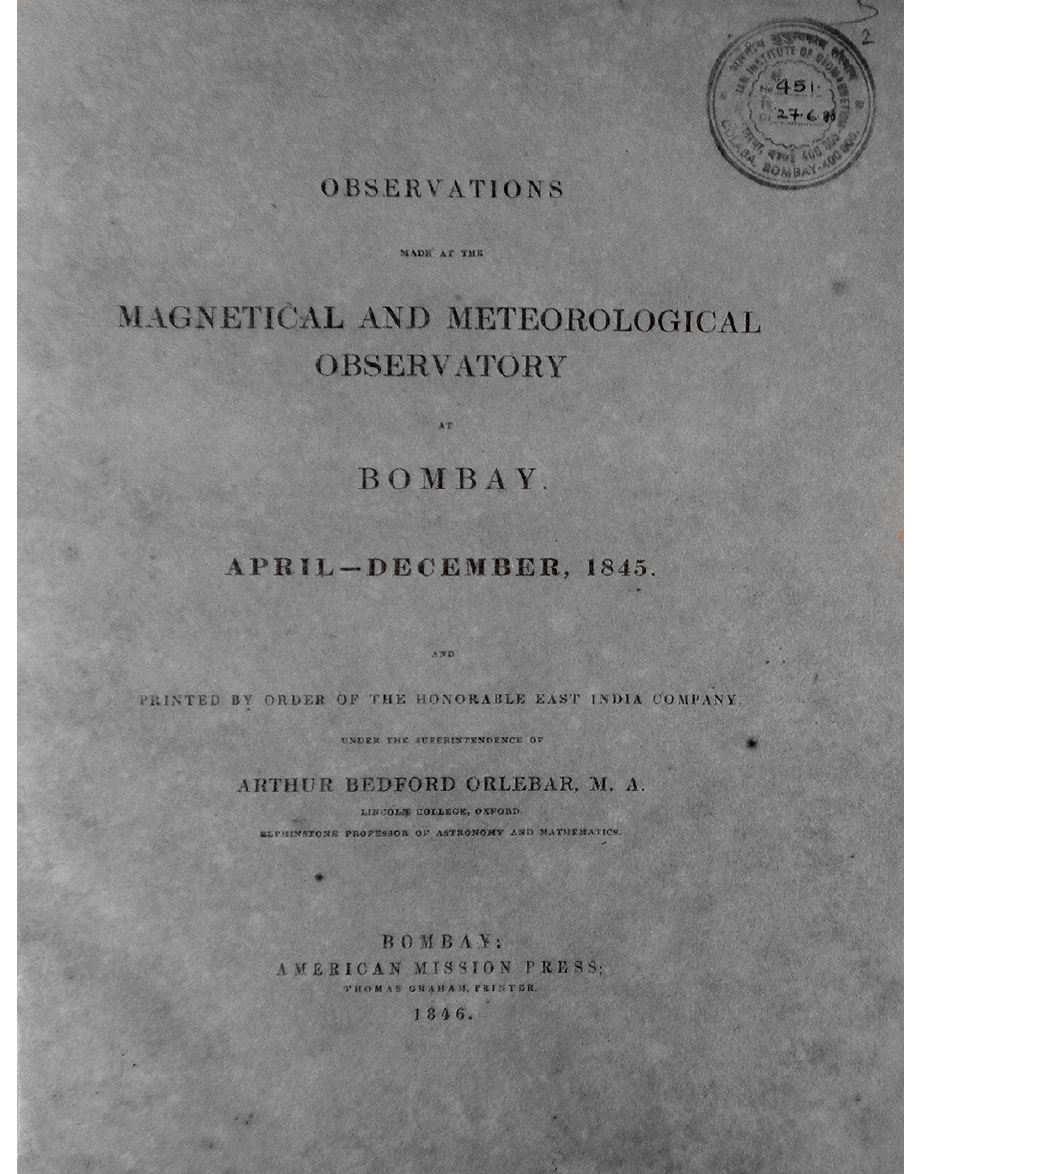
Figure 4. The cover page of the first volume reporting magnetic and meteorological observations at Colaba. It contains a detailed history of how magnetic instruments reached Colaba and the teething problems experienced in its initial years (Orlebar,